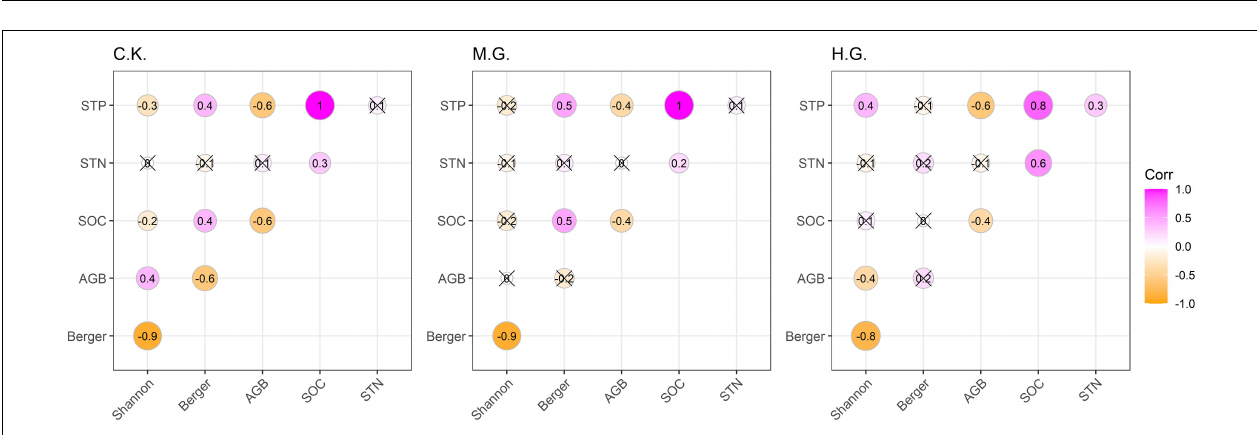
FIGURE 5 | Correlation matrix of soil nutrients, AGB, and biodiversity indices for each of the three grazing treatments. The three treatments include grazing exclusion (C.K.), moderate grazing (M.G.), and heavy grazing (H.G.). The “ × ” symbol means that the correlation coefficient does not reach the significance level, P > 0.05.